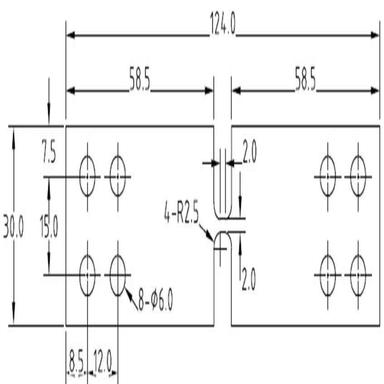
Sheet-type compression test specimen for ductile fracture.